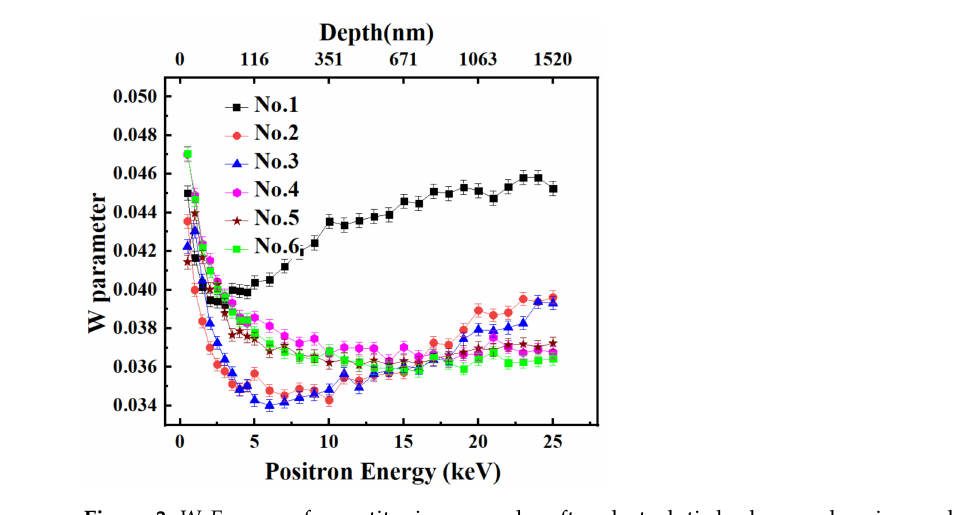
Figure 3. W - E curve of pure titanium samples after electrolytic hydrogen charging under different annealing conditions.